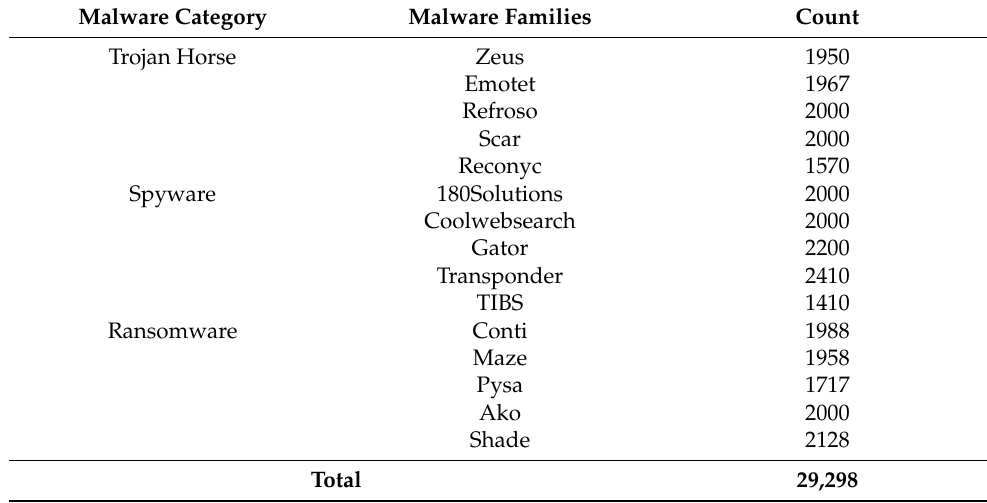
Table 3. Malware samples used in the classification training and